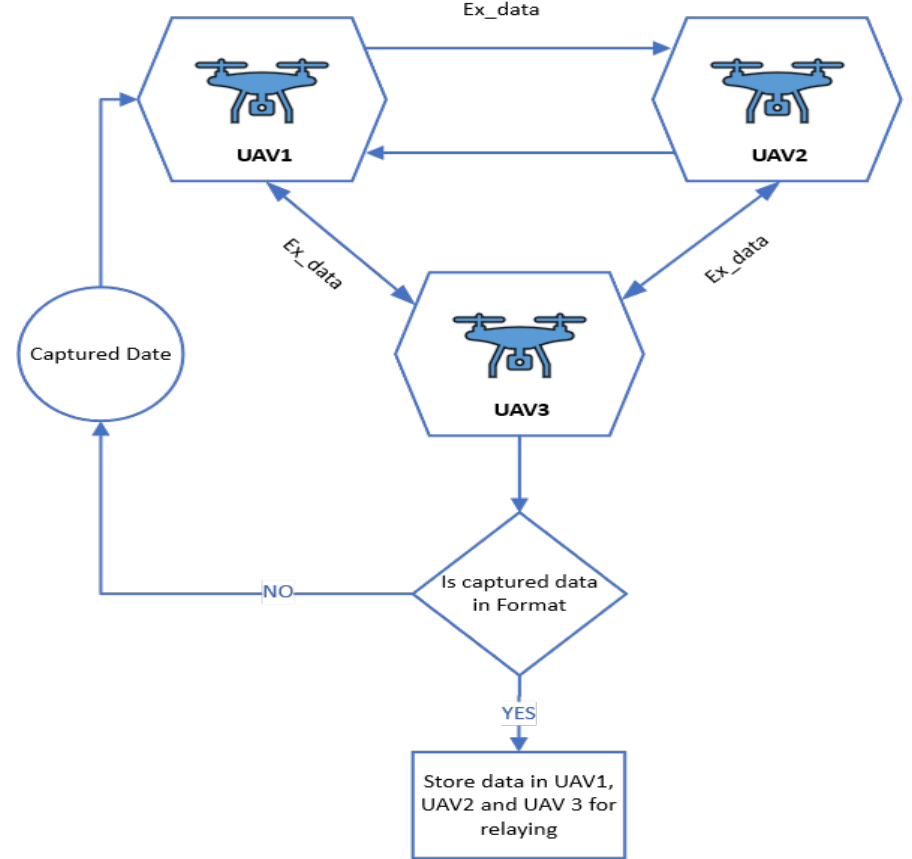
Figure 5. Operation Sequence for the UAV-based FANET communication.